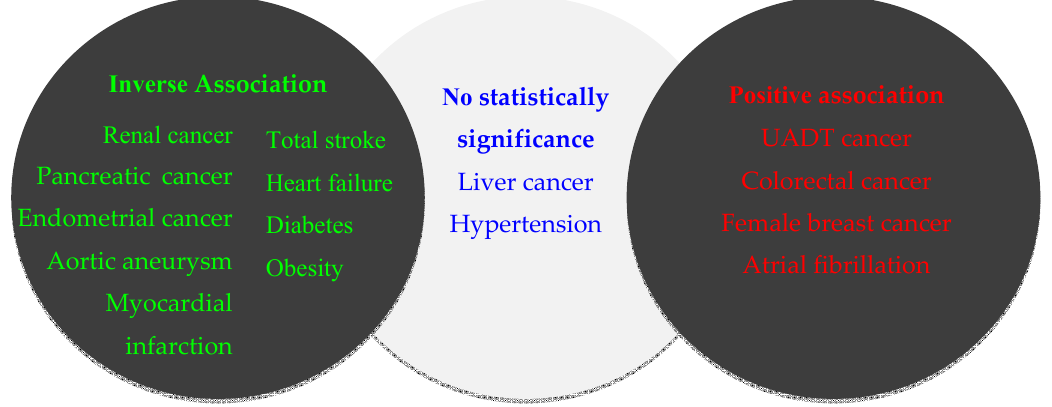
Figure 1. Association between 13.5 g/day of alcohol consumption and disease risks.